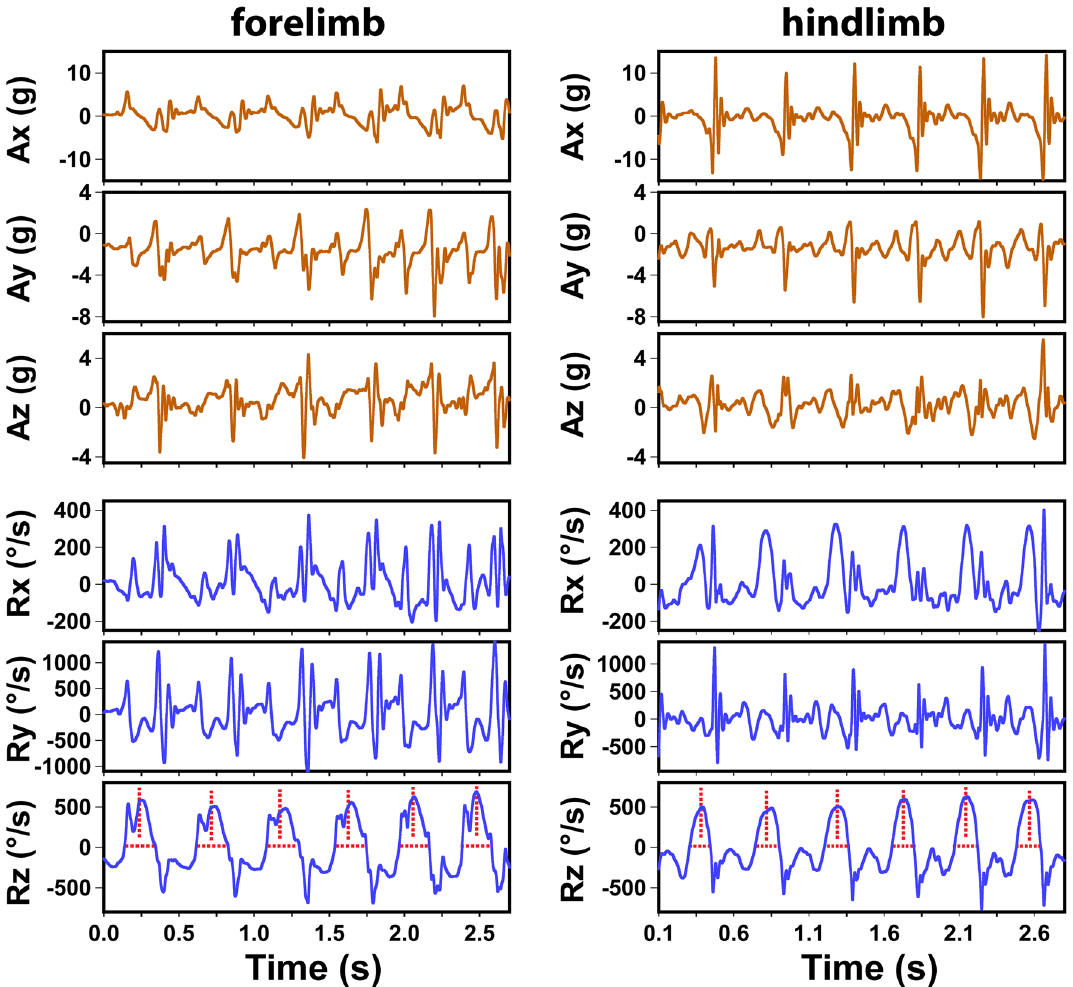
Figure 2. Representative IMU signals (3-axis accelerometer readings Ax, Ay, and Az and 3-axis gyroscope readings Rz, Ry, and Rz) acquired from a forelimb and a hindlimb of a dog. Vertical dashed lines mark the center of the Rz peak, and horizontal dashed lines indicate the width of the Rz